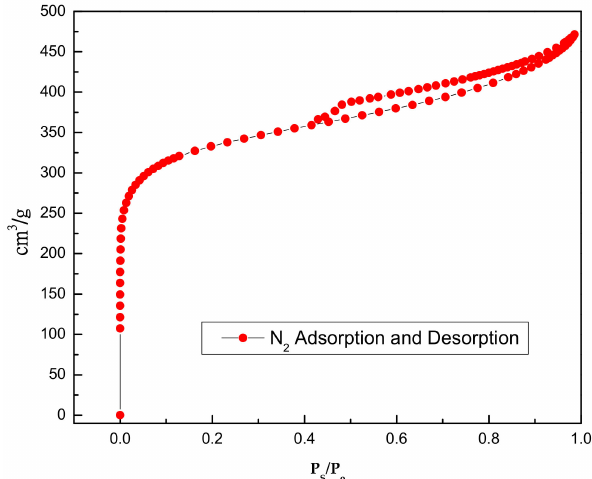
Figure 8. Activated carbon BET hysteresis